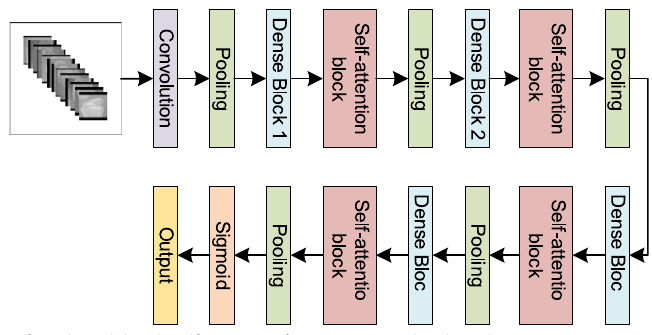
Fig. 5 The transferred model with self-attention for ROI maturity level prediction